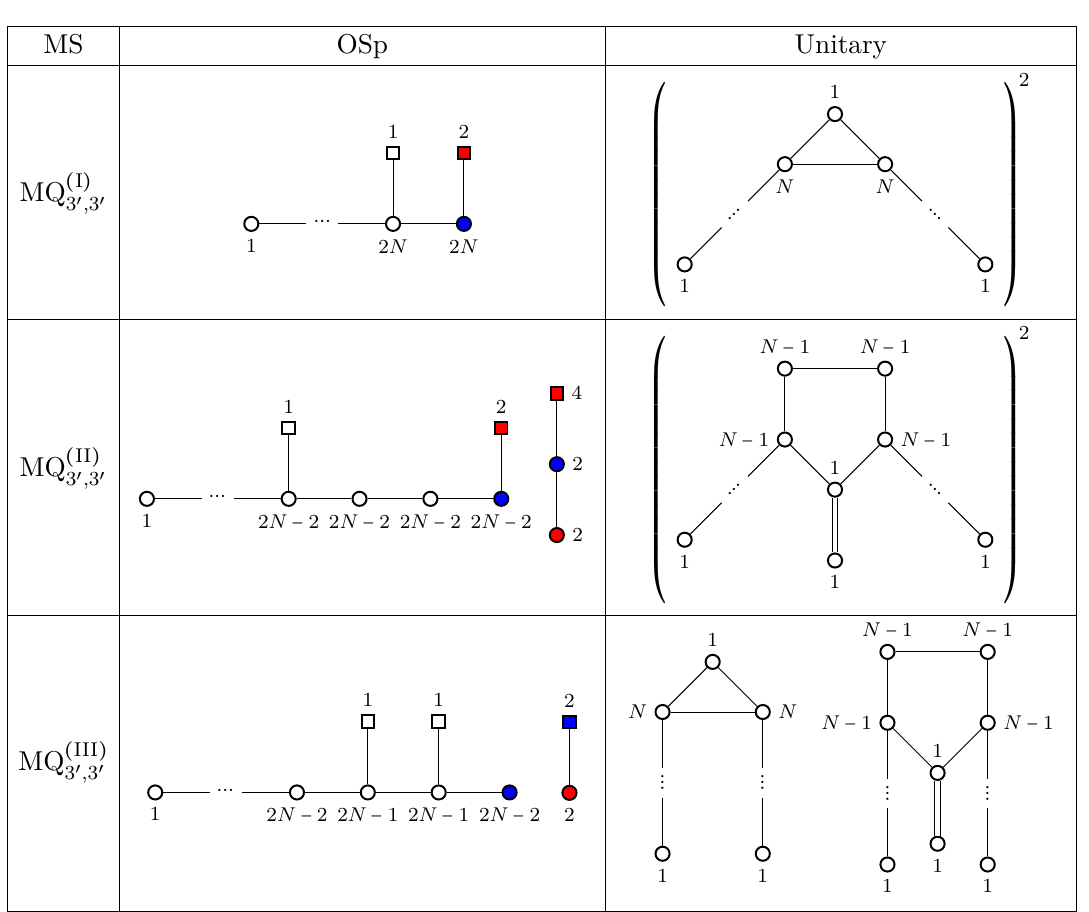
Table 4. Magnetic quivers for the E ′